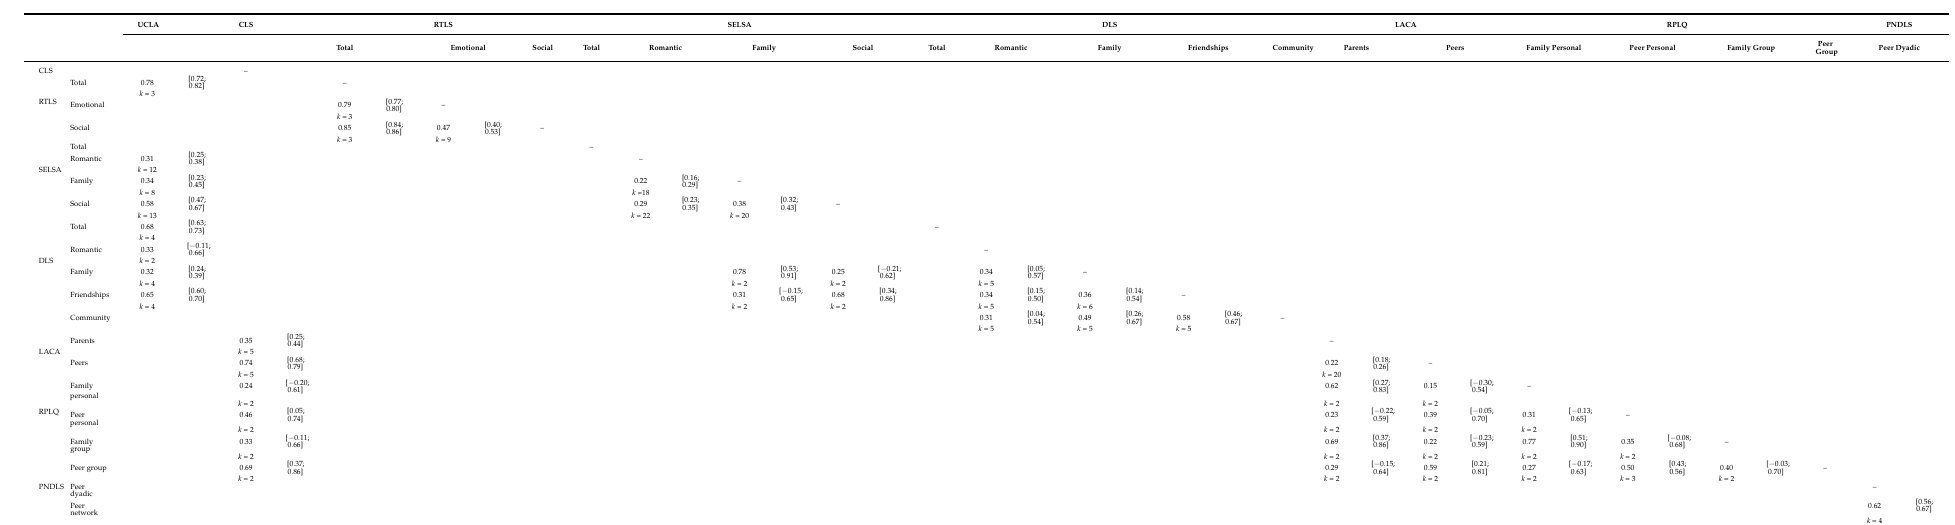
Table 9. Results of the Separate Meta-Analyses on the Correlations Among Loneliness